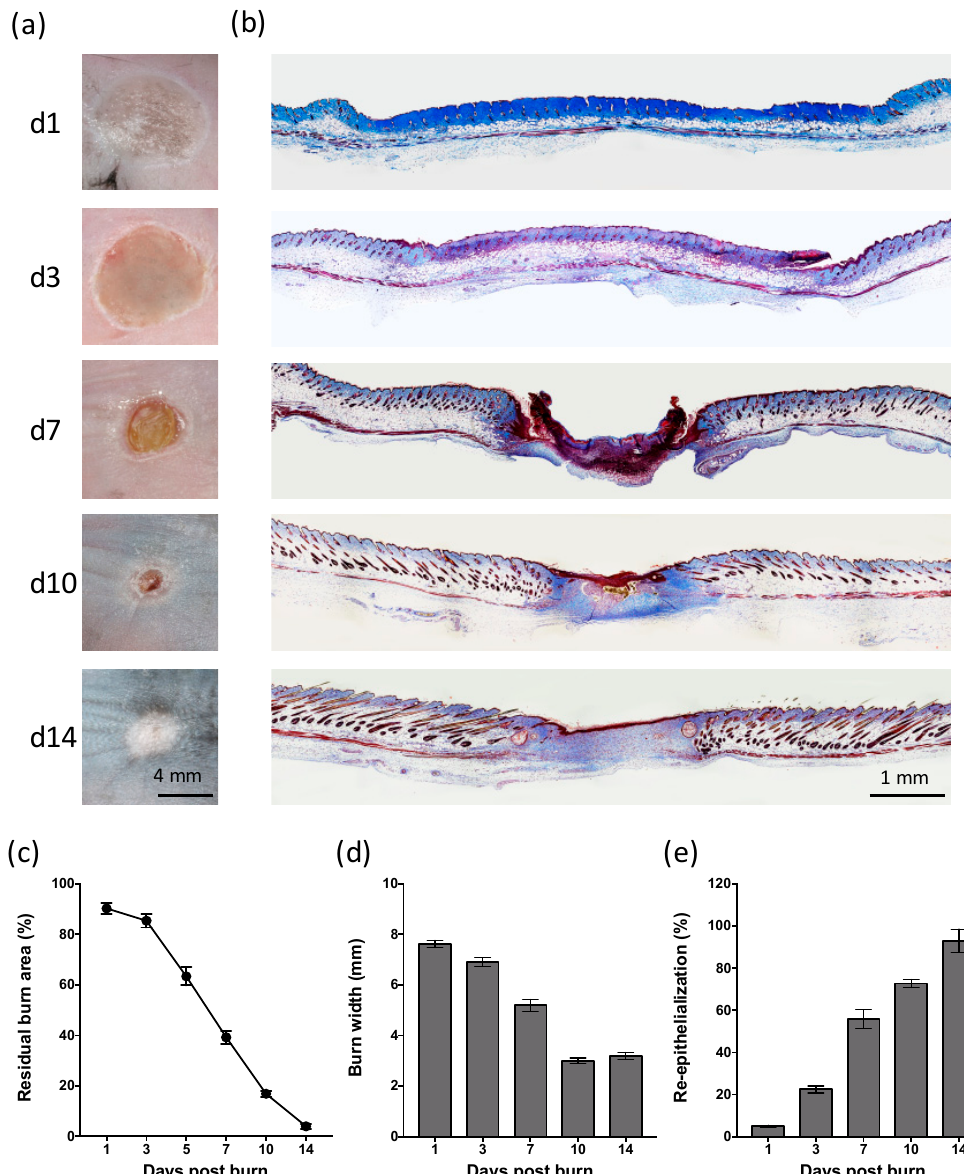
Figure 1. Heated metal rod burns heal through contraction and re-epithelialization. ( a ) Photographs and ( b ) images of Martius, Scarlet and Blue (MSB)-stained sections of healing skin at the indicated day post thermal burn. Scale is as indicated. ( c ) Burn closure is shown as a change in the percentage of the original burn area over-time. ( d ) Burn contraction is shown as the change in burn width over-time. ( e ) Burn re-epithelialization is shown as the change in the percentage neo-epidermal coverage over-time. Data represents the mean ± SEM, n = 8.